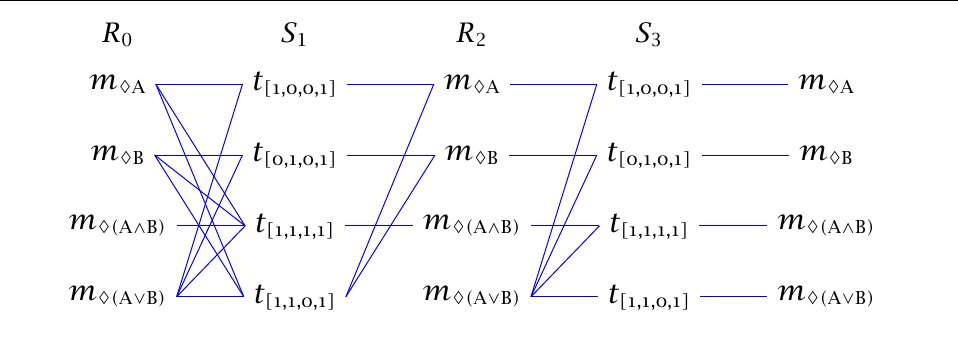
Figure 12 Predictions for fc -disjunctions with conjunctive